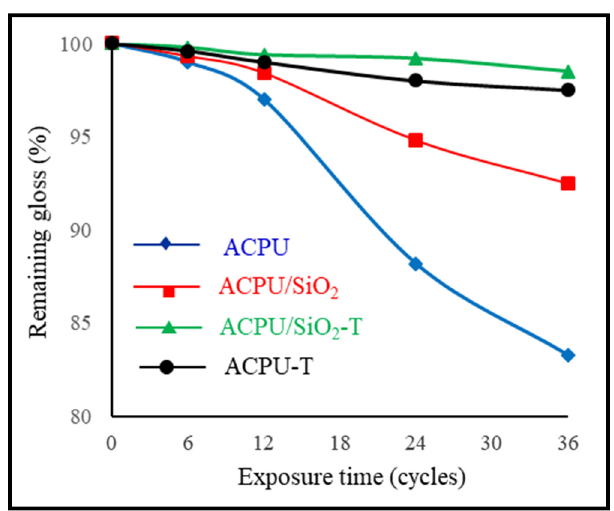
Figure 7. Changes in gloss of the coatings under accelerated weathering aging condition.